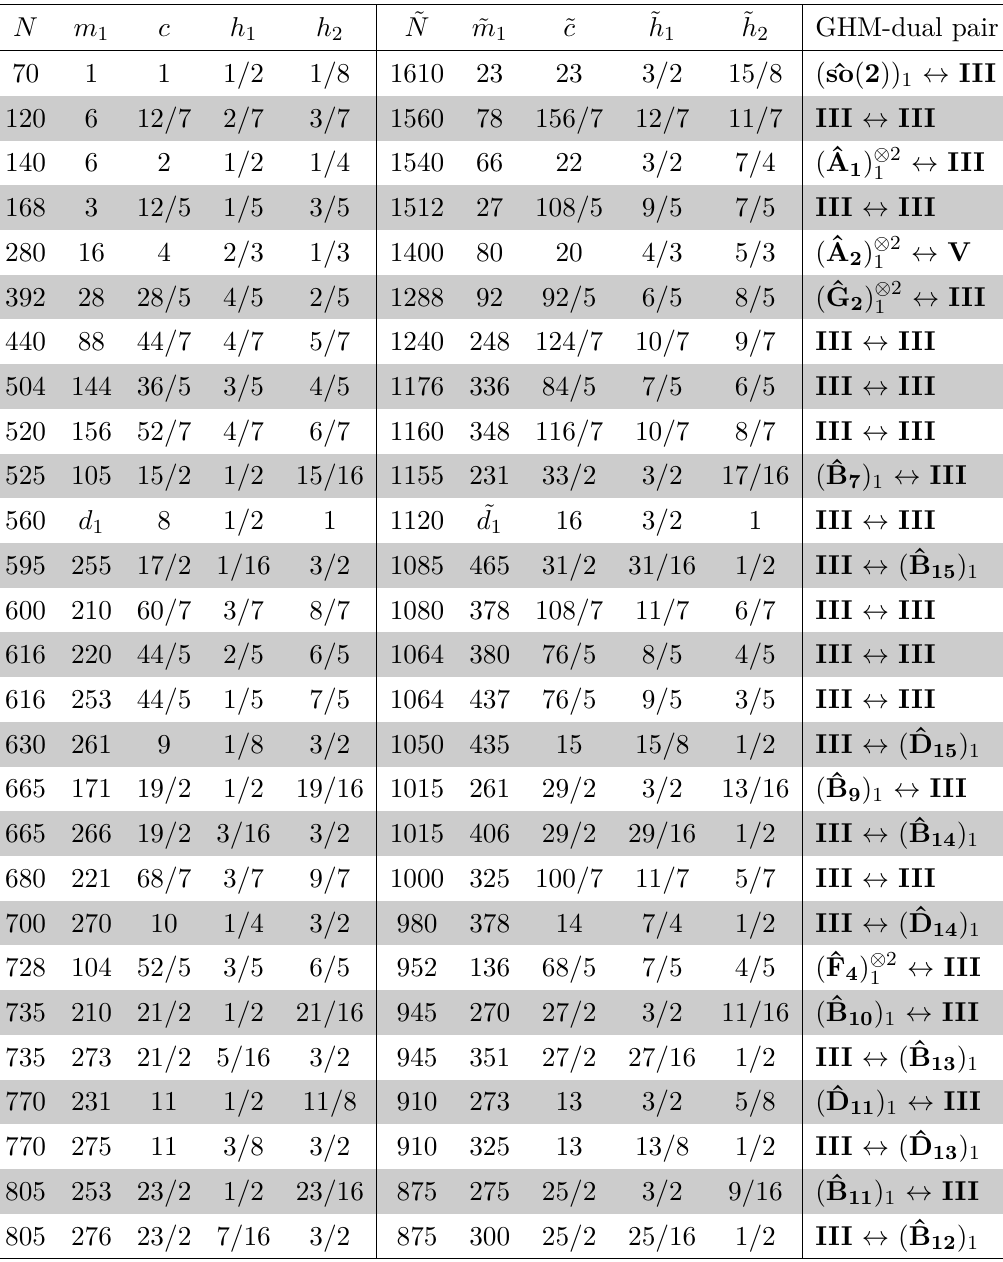
Table 10 . Potential GHM-dual Pairs of [ 3 , 0 ]